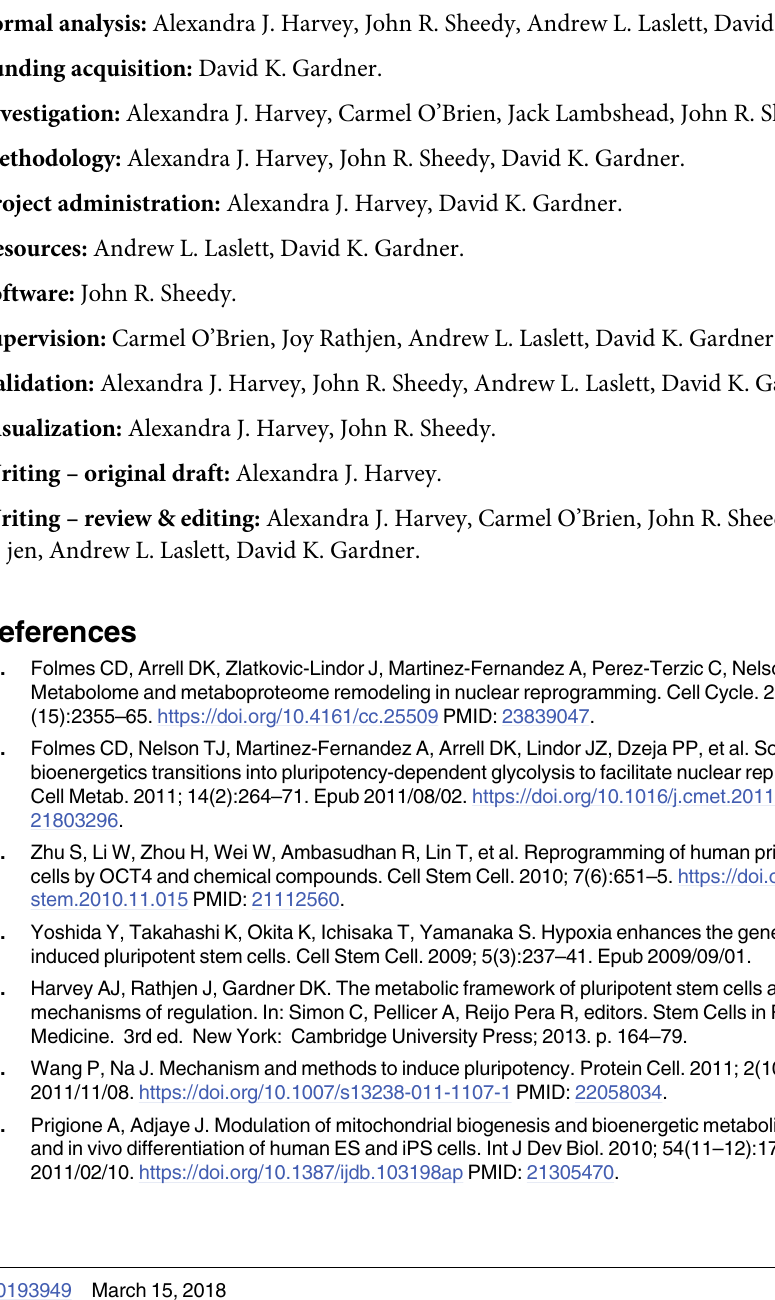
S2 Fig. Carbohydrate utilisation in PDL (A, B) and IMR90 (C, D) fibroblasts in response to oxygen. ( A, C ) Glucose consumption, quantified in spent medium samples, normalised to cell number and an unspent medium control. ( B, D ) Lactate production, quantified in spent medium samples, normalised to cell number and an unspent medium control Black bars: 5% oxygen; white bars: 20% oxygen. Data are presented as mean ± SEM; n = 3 samples per line per treatment. (cid:3)(cid:3) P = 0.01, (cid:3)(cid:3)(cid:3) P =